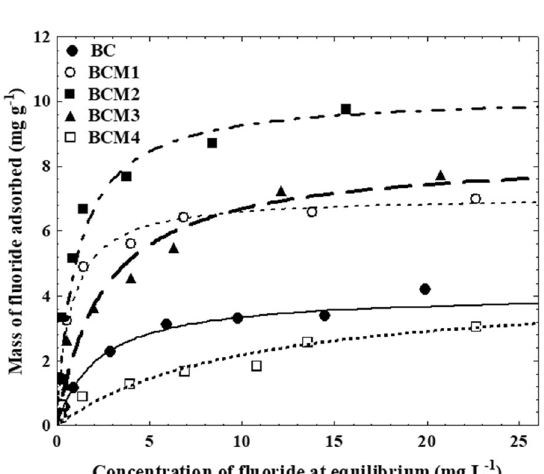
Fig. 7 Adsorption isotherms of fluoride from aqueous solution onto BC, BCM1, BCM2, BCM3 and BCM4, at T represent the Langmuir isotherm